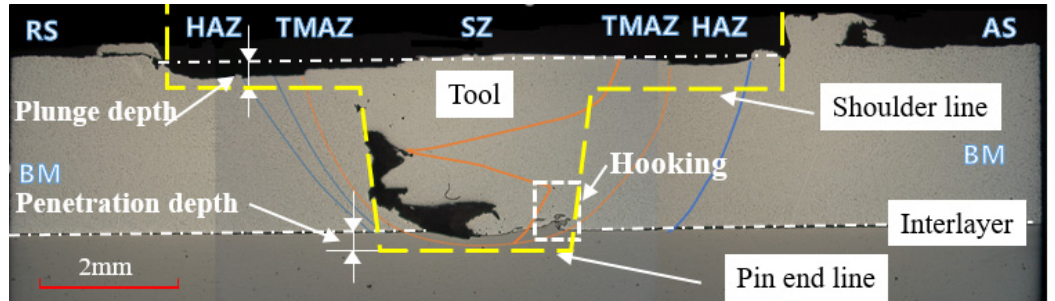
Figure 8. Optical microscope image of the cross-section of lap joints and the dimensions of plunge depth and tool penetration depth.